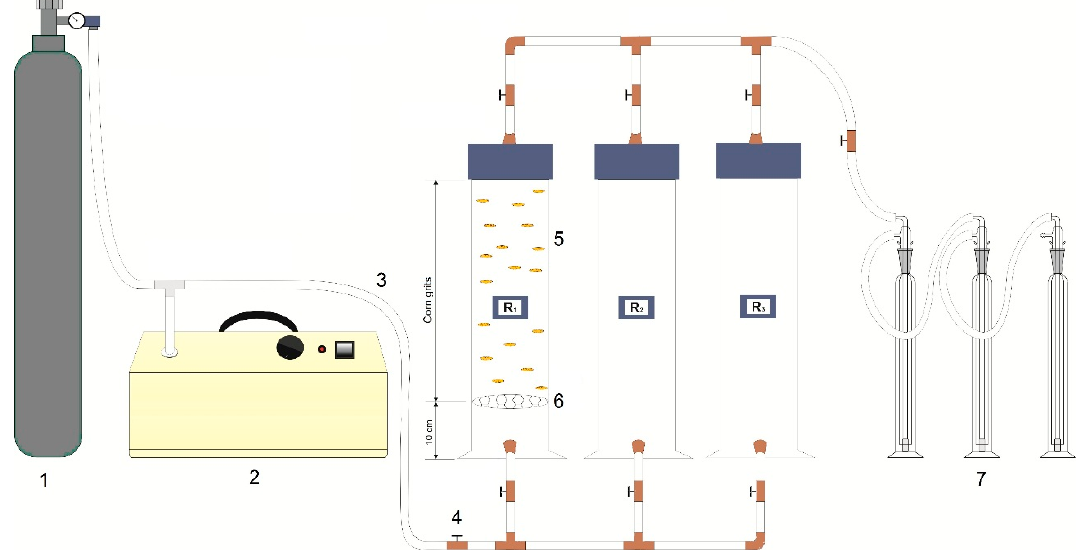
Figure 1. Ozonation system. 1—O 2 cylinder/flux control valve; 2—Ozone generator; 3—Silicone hoses; 4—Copper connections; 5—PVC cylinders containing the corn grits; 6—Polyamide silicone support disk; 7—Gas wash bottles with potassium iodide solution. Table 1. Matrix of the full factorial design with coded and real values.